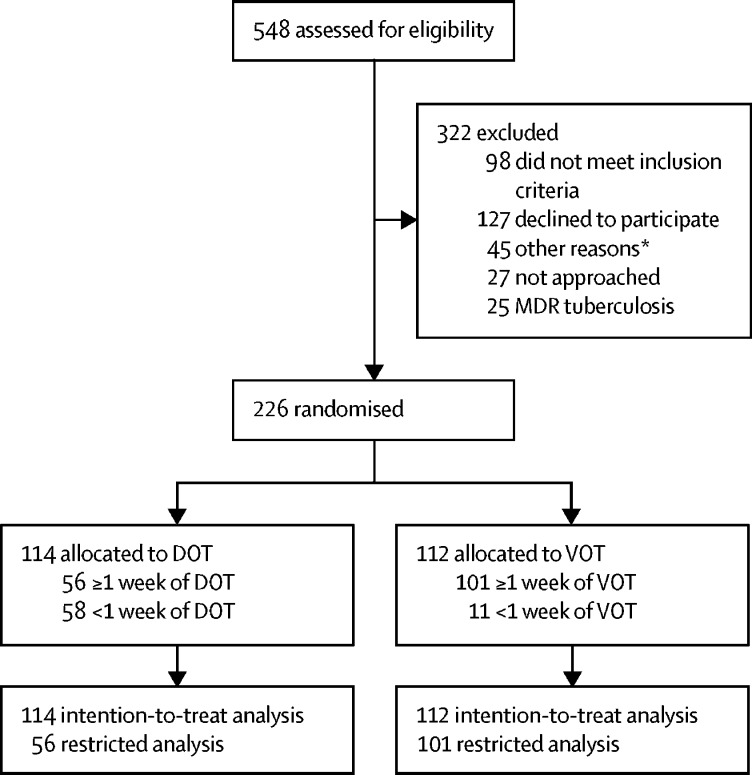
Enrolment and randomisationMDR=multi-drug resistant. *The most common other reason for not enrolling patients (32 of 45) was clinic staff considering that the patient needed intensive face-to-face support for emotional, medical, or physical reasons, or because of imminent risk of loss to follow-up. Characteristics of eligible patients who were approached but refused to take part in the study are in the appendix.